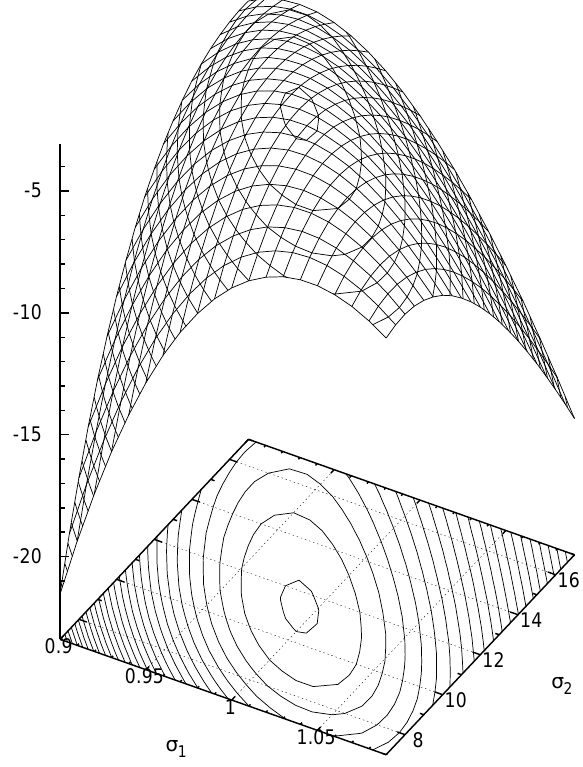
Fig. 2. Simulated data: Log-likelihood as a function of the noise